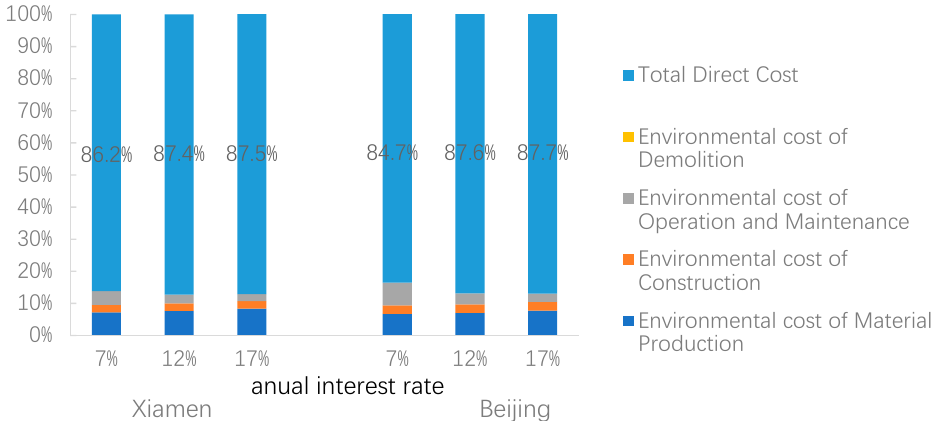
Figure 5. Ratio of environmental cost to direct cost considering different discount rate.